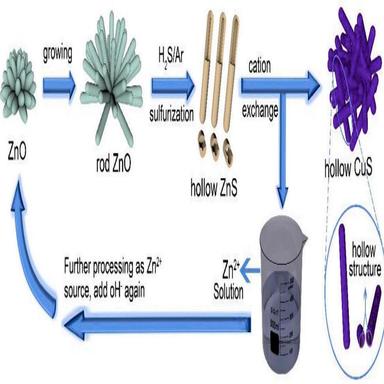
Schematic illustration for the synthetic procedure of hollow copper sulfide.